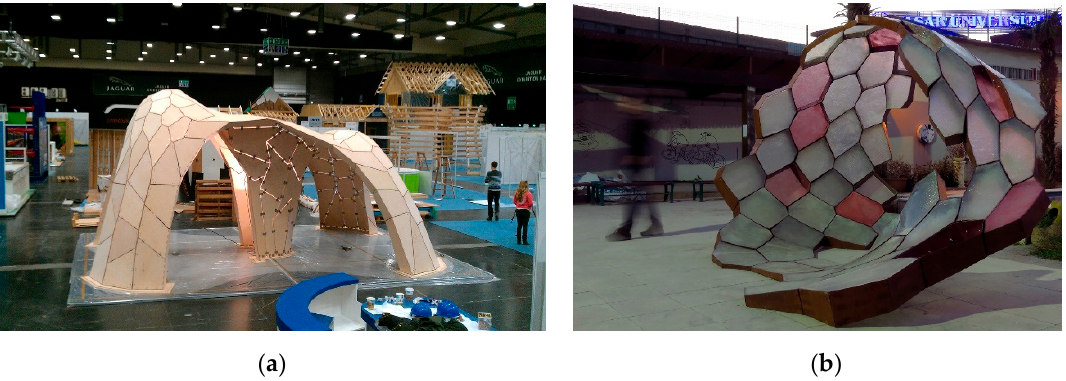
Figure 2. Temporary pavilions: ( a ) the TRADA Pavilion, 2012, reproduced with permission from John Harding; ( b ) TU Delft and Yasar University Pavilion, 2015, reproduced with permission from Serdar Asut.